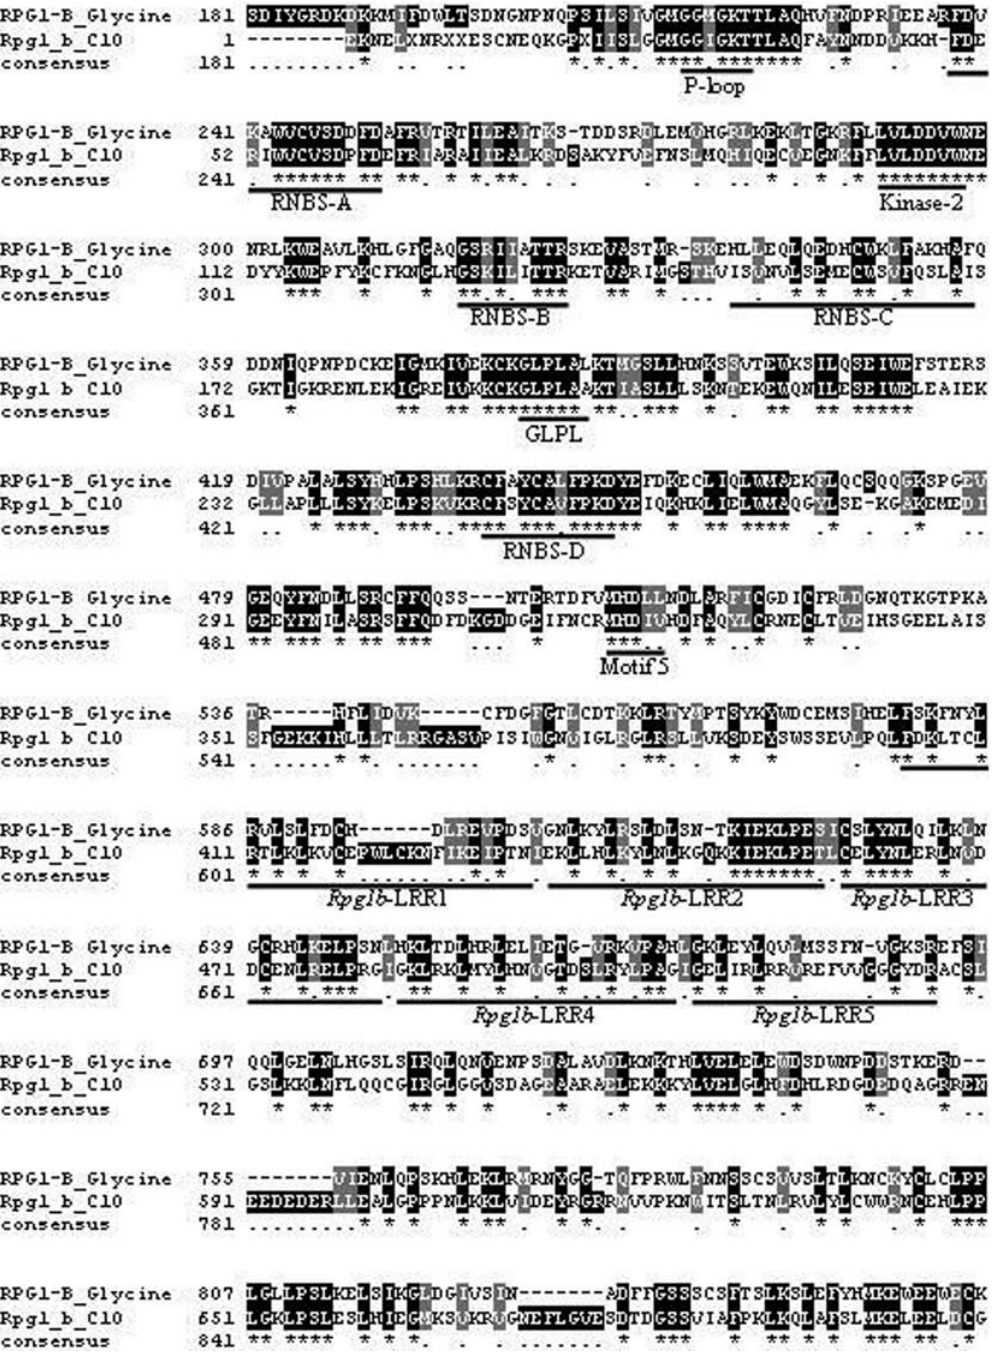
Figure 3 - Alignment of the CitEST contig C10 and RPG1-B from Glycine max (GenBank Accession Number AAR19097). Amino acids boxed in black